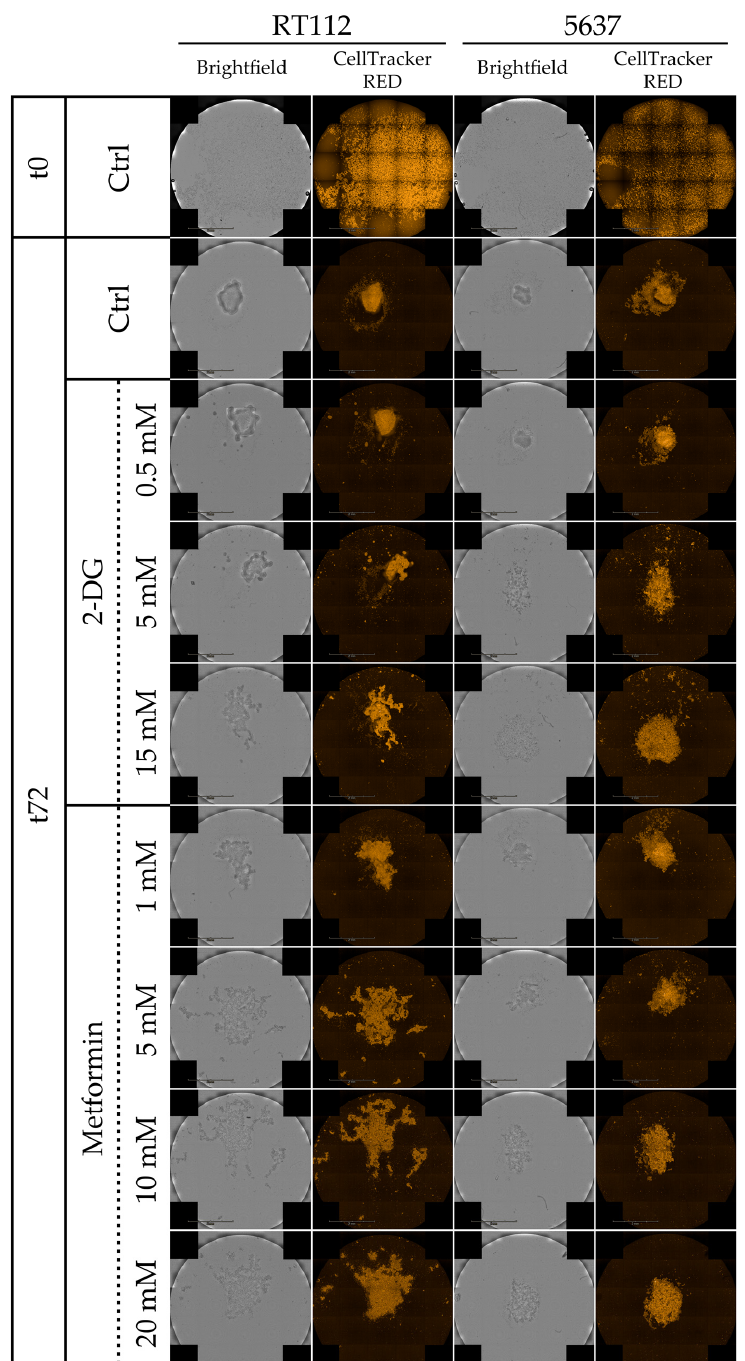
Figure 8. Spheroid formation under pharmacological treatment of RT112 and 5637 cells. Representative images from brightfield and fluorescence microscopy (orange: CellTracker ™ Red CMTPX Dye) acquired with Operetta CLS ™ at 0 h and 72 h of cells grown in cell repellent 96-well plate under treatment with increasing concentration of 2-Deoxy-D-glucose (2-DG) (0, 0.5, 5, 15 mM) and metformin (0, 1, 5, 10, 20